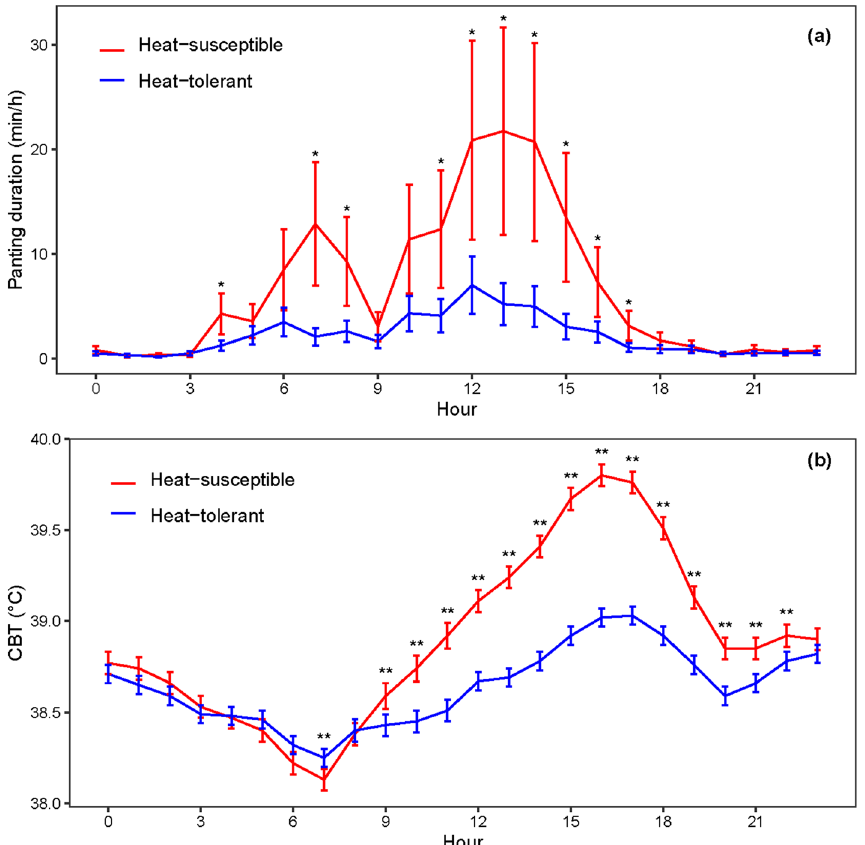
Figure 1. Differences in ( a ) panting duration and ( b ) mean core body temperature (CBT) between heat- tolerant and heat-susceptible cattle across hours of the day based on raw data. Average visual panting score (PS) data of first 40 days on feed were used for categorising cattle into heat-tolerant (PS < 1, n = 11) and heat- susceptible (PS ≥ 1, n = 8). The automated continuous CBT and panting data were collected from day 63 to 66. Each cow had 410 (10-min time intervals) CBT and 68 (1-h time interval) panting duration records across 68.2 h of continuous observation. Asterisks denote when differences were statistically significant (* for P < 0.05, ** for P < 0.01) and the error bars denote standard errors